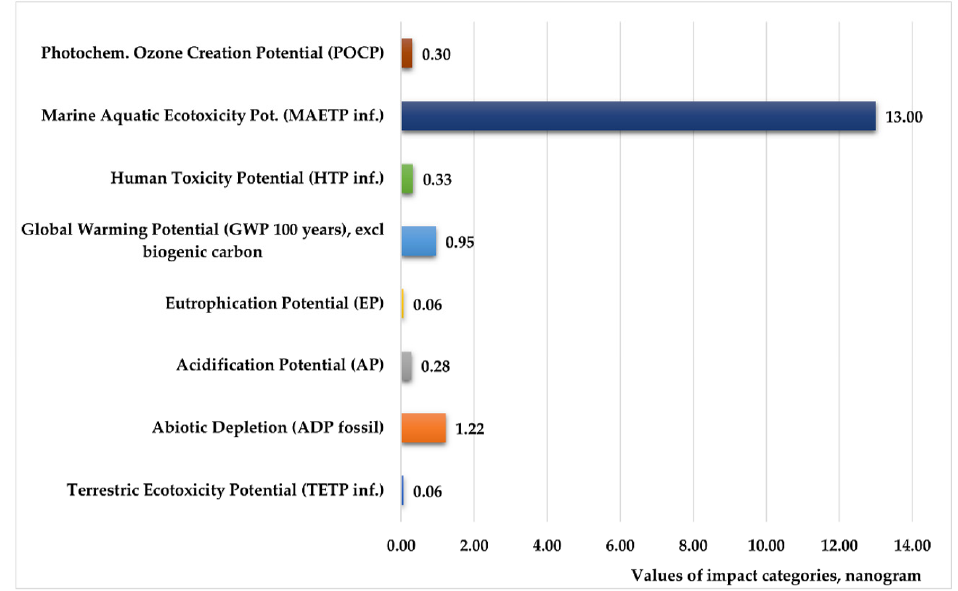
Figure 6. Normalized and weighted values in the wet grinding process in nanograms. (Functional unit: 1 kg of limestone product. Impact assessment method: CML 2001/Aug. 2016. Normalization reference: CML 2016, EU, year 2000, excl. biogenic carbon. Weighting method: thinkstep LCIA Survey 2012, Europe, CML 2016, excl. biogenic